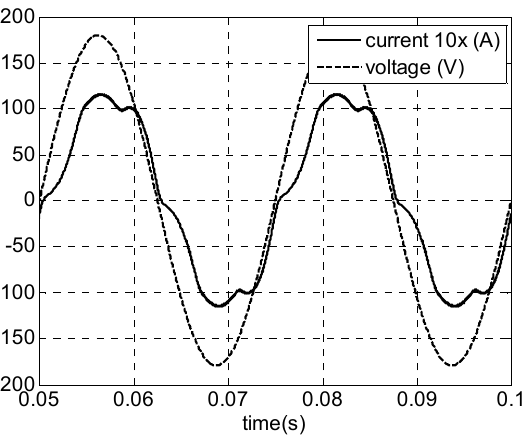
Figure 5. Semi-controlled boost rectifier.